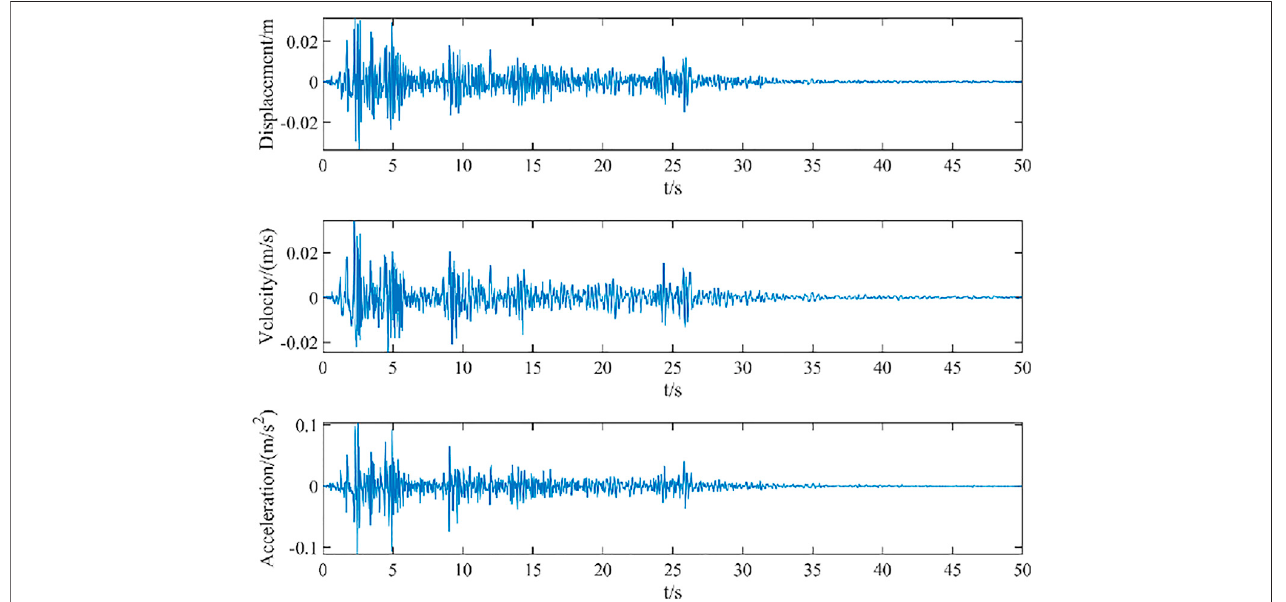
FIGURE 14 | Dynamic response of displacement, velocity, and acceleration output of original truss model.